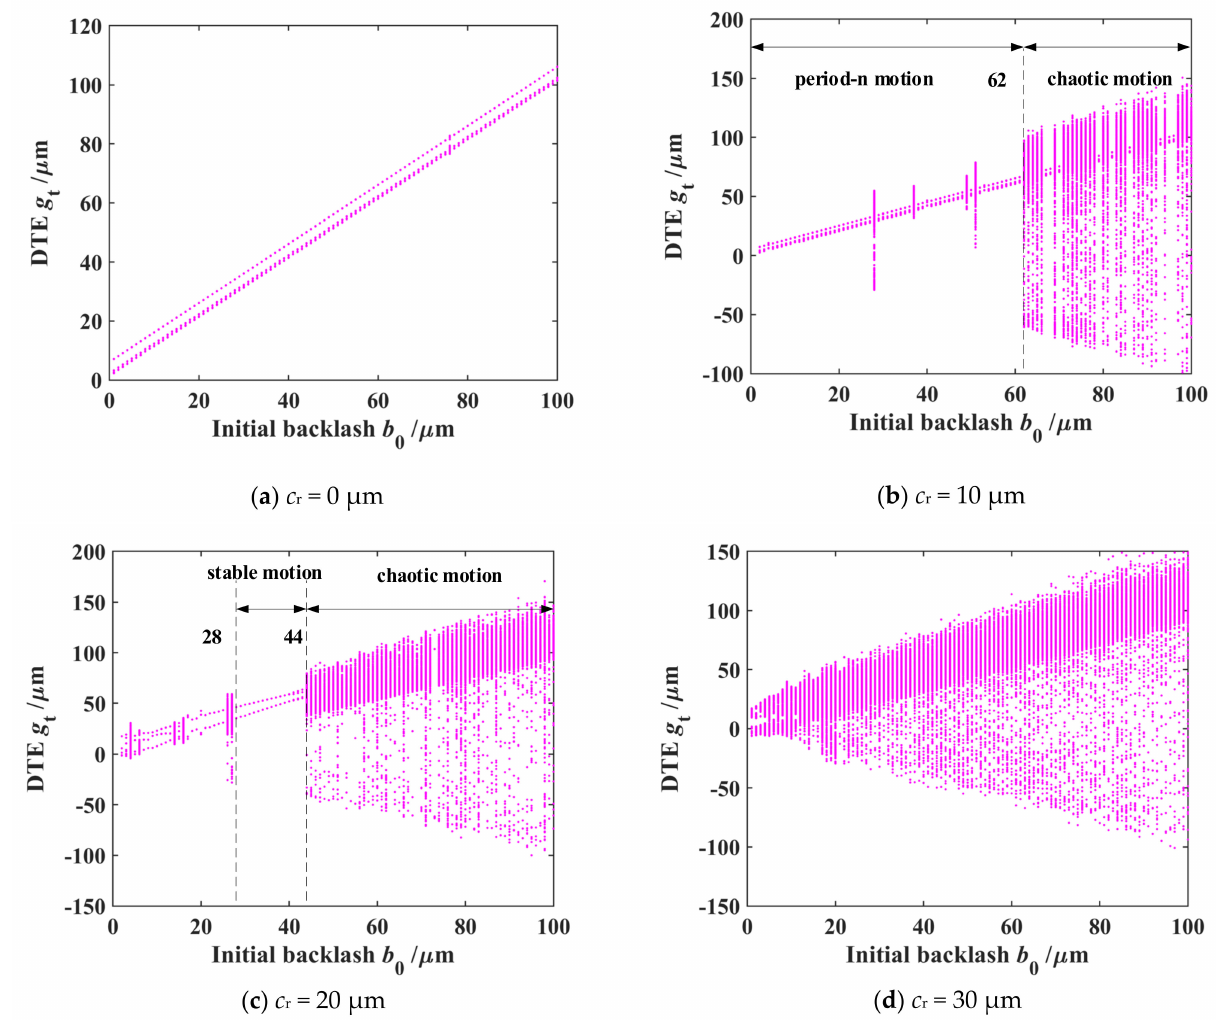
Figure 20. Bifurcation diagrams of DTE response with respect to initial gear backlash under different bearing